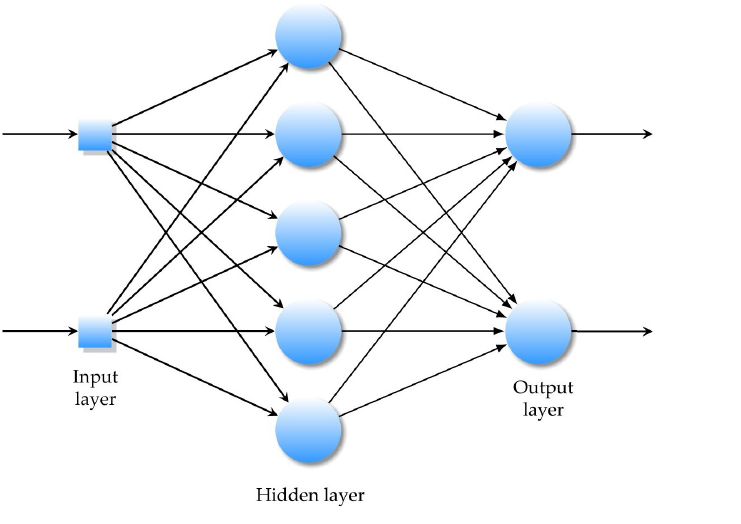
Figure 6. A multilayer feedforward ANN with one hidden